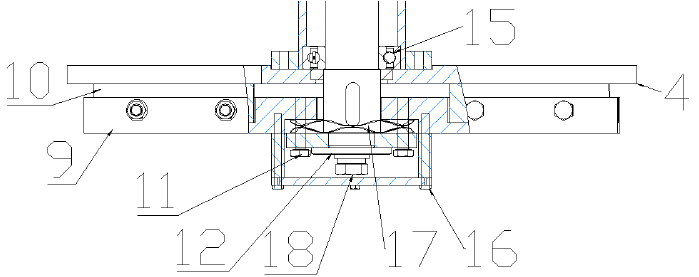
Figure 3. Cross rotary cutter group. (4) cutter head, (9) cross tool holder, (10) blade, (11) Bolt guide, (12) shaft end washer, (15) bearing, (16) fixed bolt, (17) multilayer wave spring, (18) shaft end bolts.